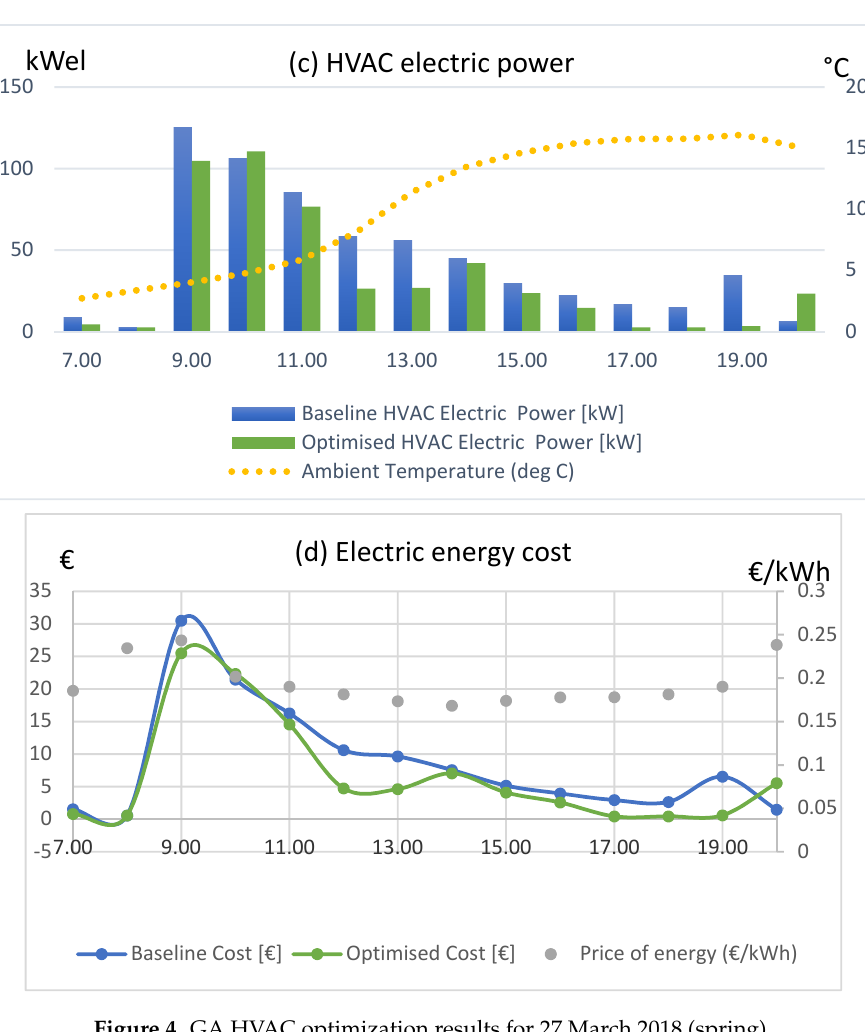
Figure 4. GA HVAC optimization results for 27 March 2018 (spring).